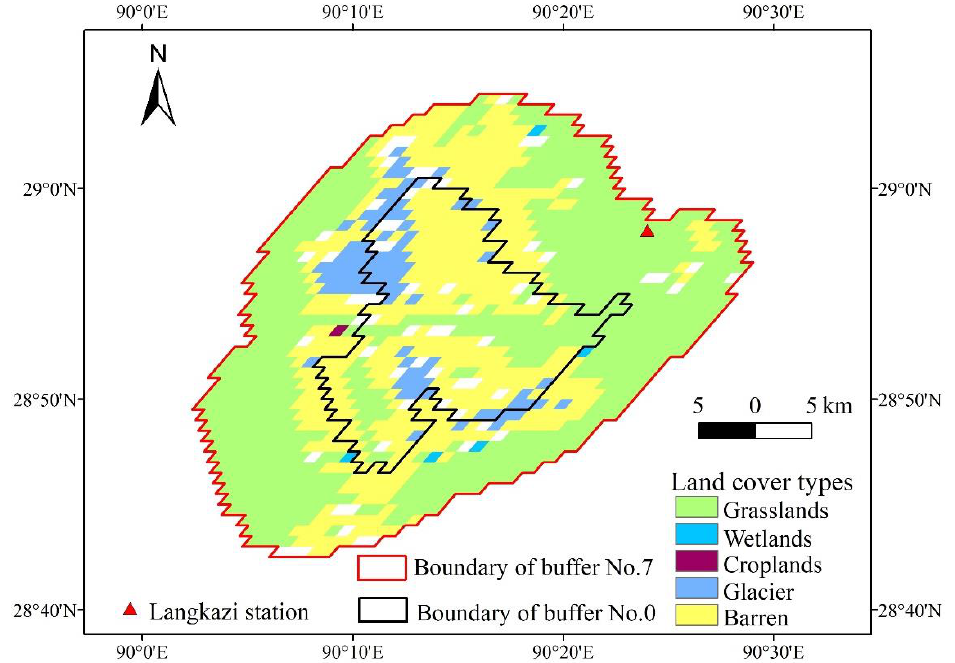
Figure 11. Comparison of distributions of land cover types between the extent of buffer No. 0 and that of buffers 0 – 7.